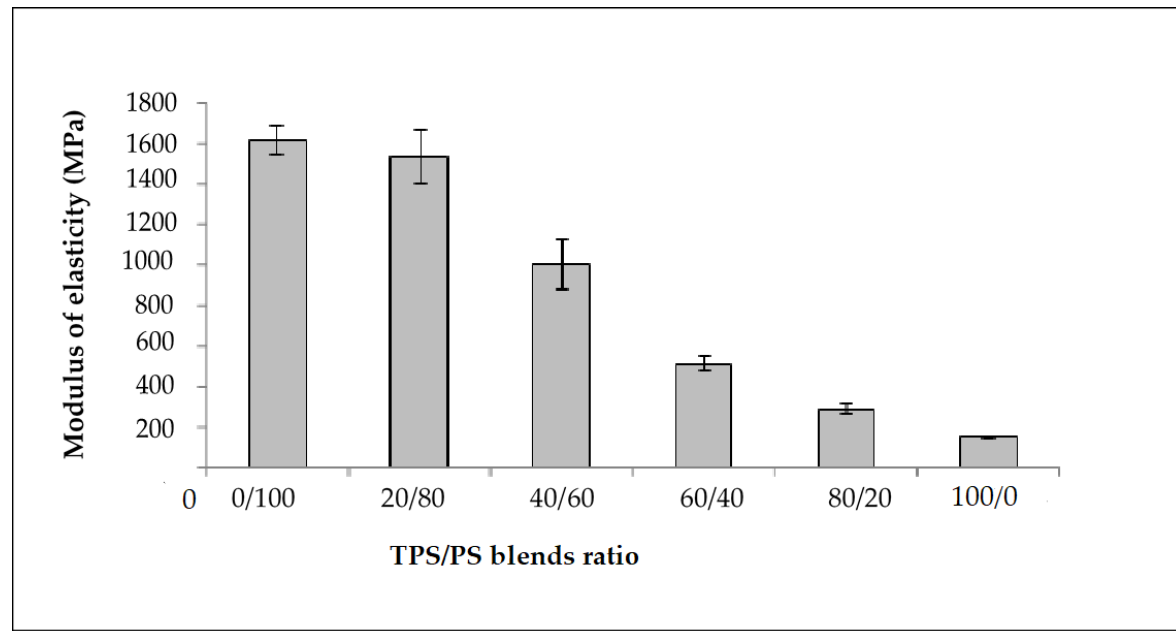
Figure 2. Modulus of elasticity of untreated of TPS/PS blends at different blends ratio.